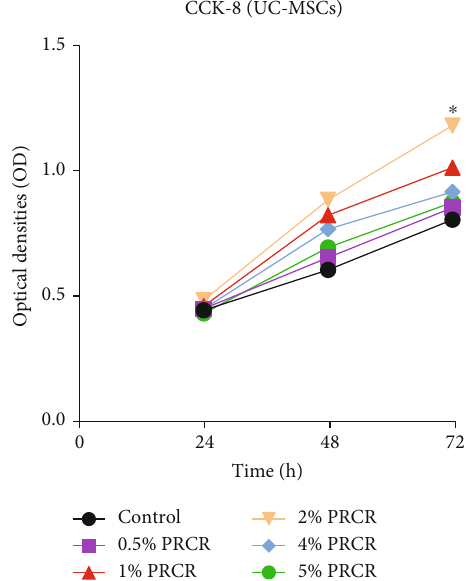
Figure 1: E ff ect of di ff erent concentrations of PRCR on UC-MSC proliferation. CCK-8 assay indicated that the UC-MSCs treated with 2% PRCR achieved maximum proliferation. n = 3 ; ∗ P < 0 : 05 , compared to the other group. PRCR: platelet-rich plasma clot releasate; UC-MSCs: umbilical cord mesenchymal stem cells; CCK-8: cell counting kit-8